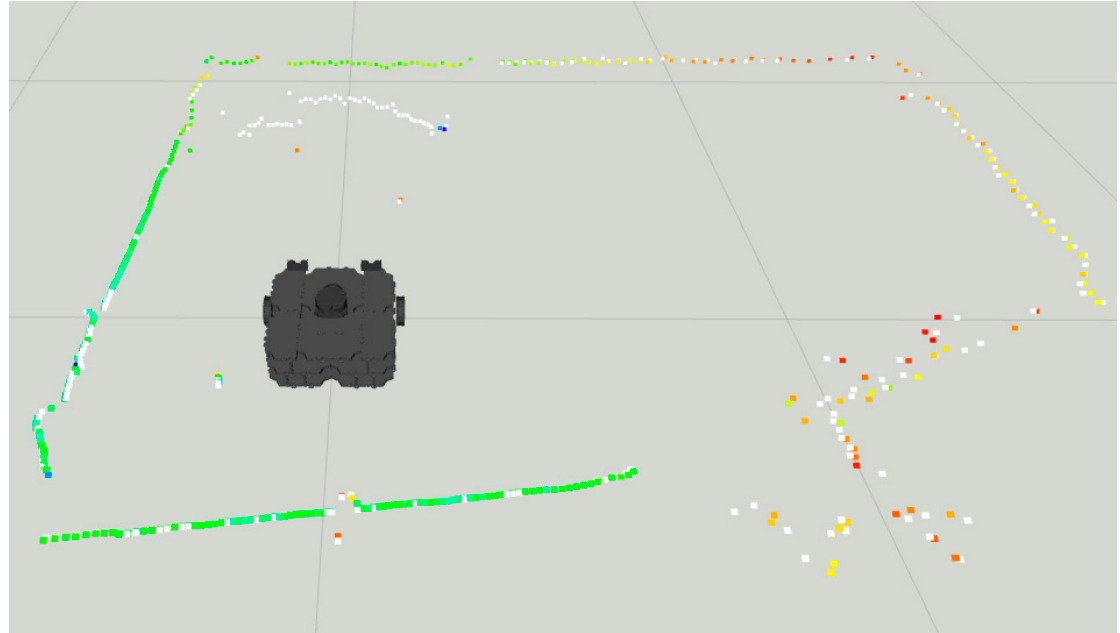
Figure 21. Distance readings pre and post fusion for LiDAR-Sonar fusion.